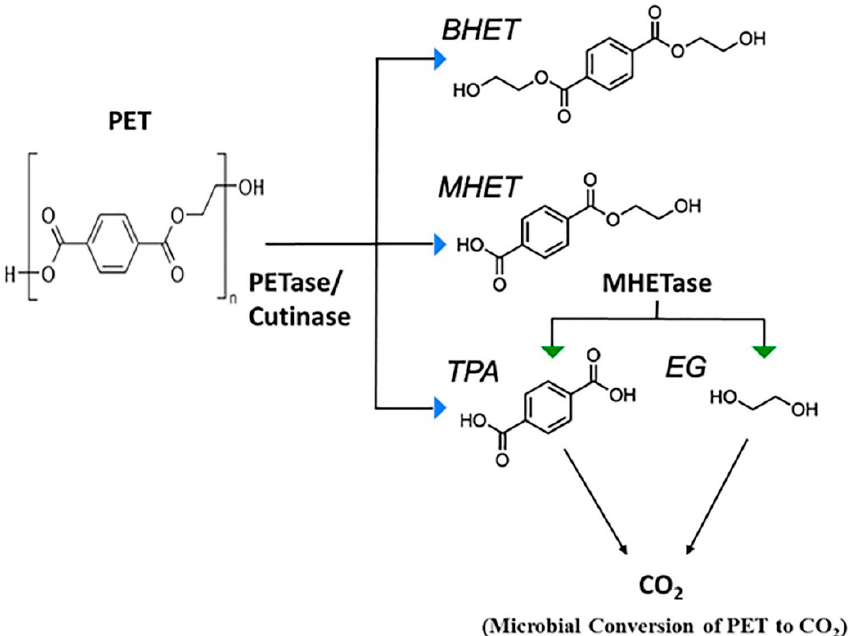
Figure 2. Microbial degradation of PET [56]. PETase , polyethylene terephthalate (PET) hydrolase or PET-digesting enzyme; BHET , bis(2-hydroxyethyl) terephthalic acid; MHET , mono(2-hydroxyethyl) terephthalic acid; TPA , terephthalic acid; EG , ethylene glycol. B. flexus has been proved to biodegrade poly (vinyl chloride) (PVC) film [67]. Bacte- Table 4. Reactions of the oxidative degradation poly(ether-urethane) [73]. ria of this species have been able to form dense biofilm on the plastic film surface and cause a decrease in the mean molecular weight of the PVC film [67]. Bacillus sp., trigger- Reaction Type Reaction